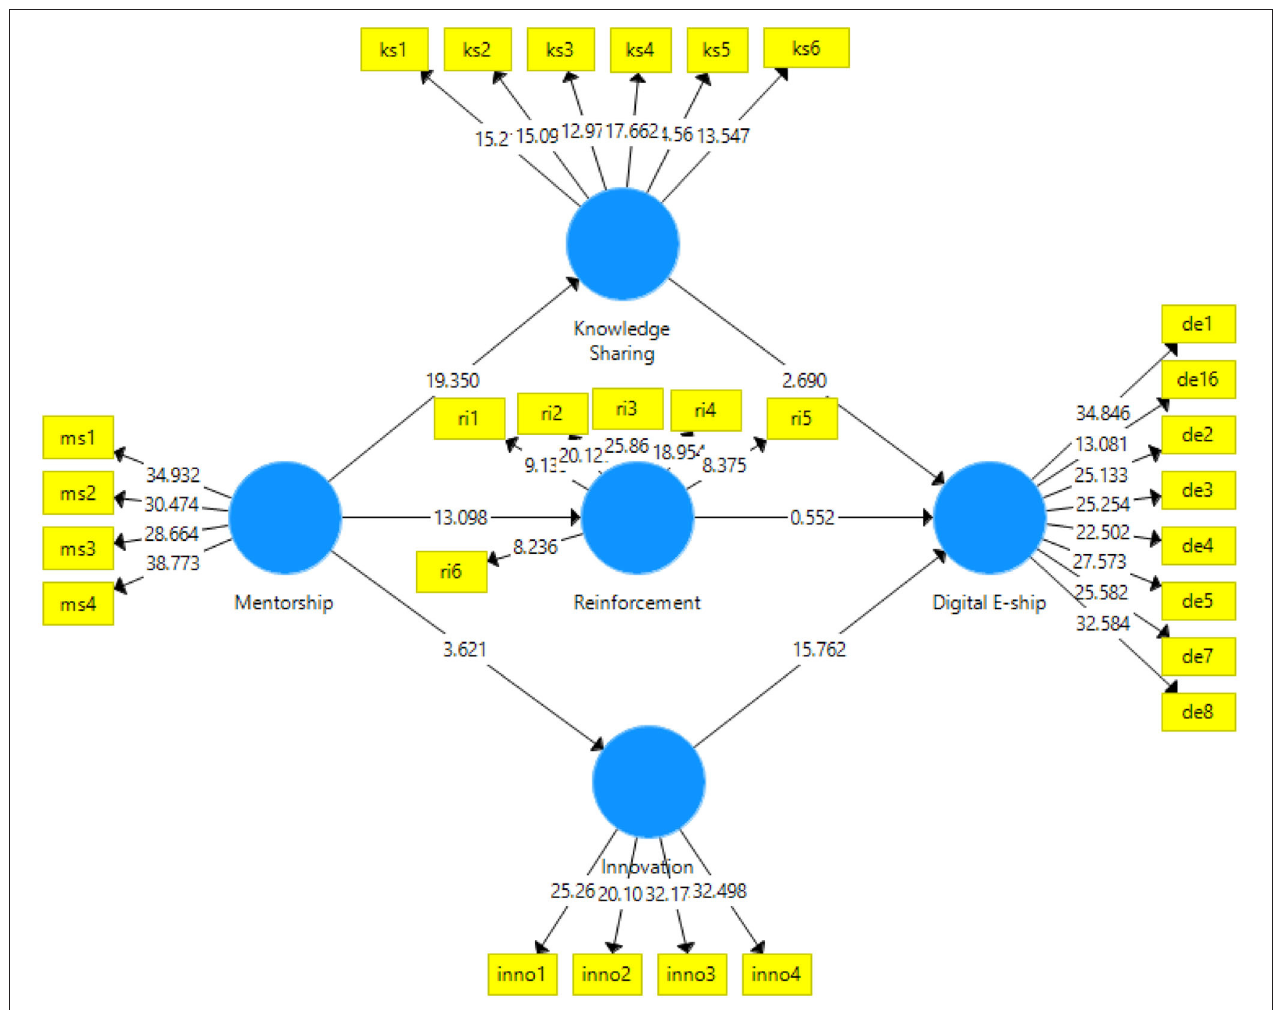
FIGURE 3 | PLS bootstrapping for a structural model. PLS, partial least